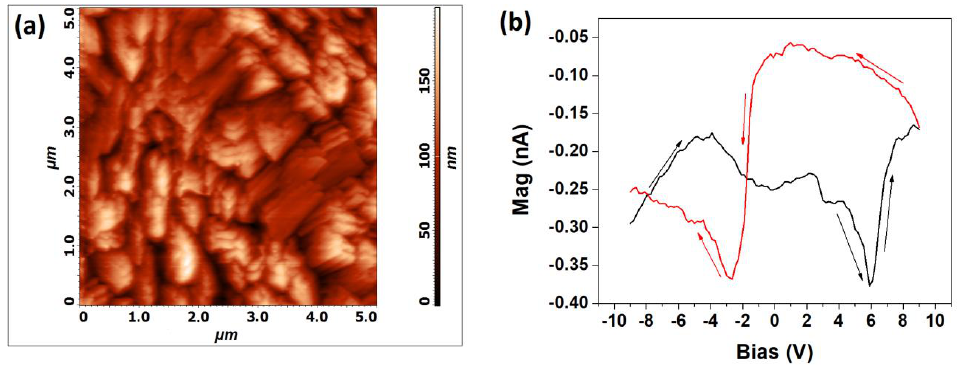
Figure 4. Arrhenius plot of the ln growth rate vs. 1000/T for the BiFeO 3 MOCVD process starting from the Bi(phenyl) 3 and Fe(tmhd) 3 precursors.